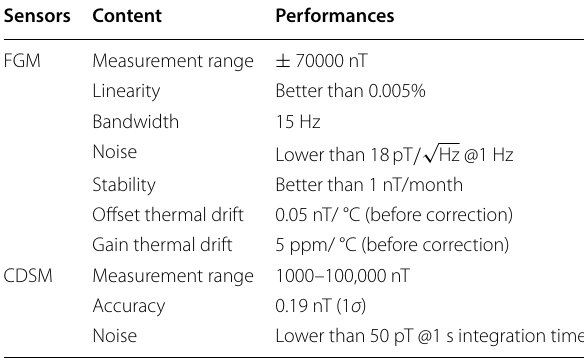
Some non-linear correction parameters are considered during the ground calibration test